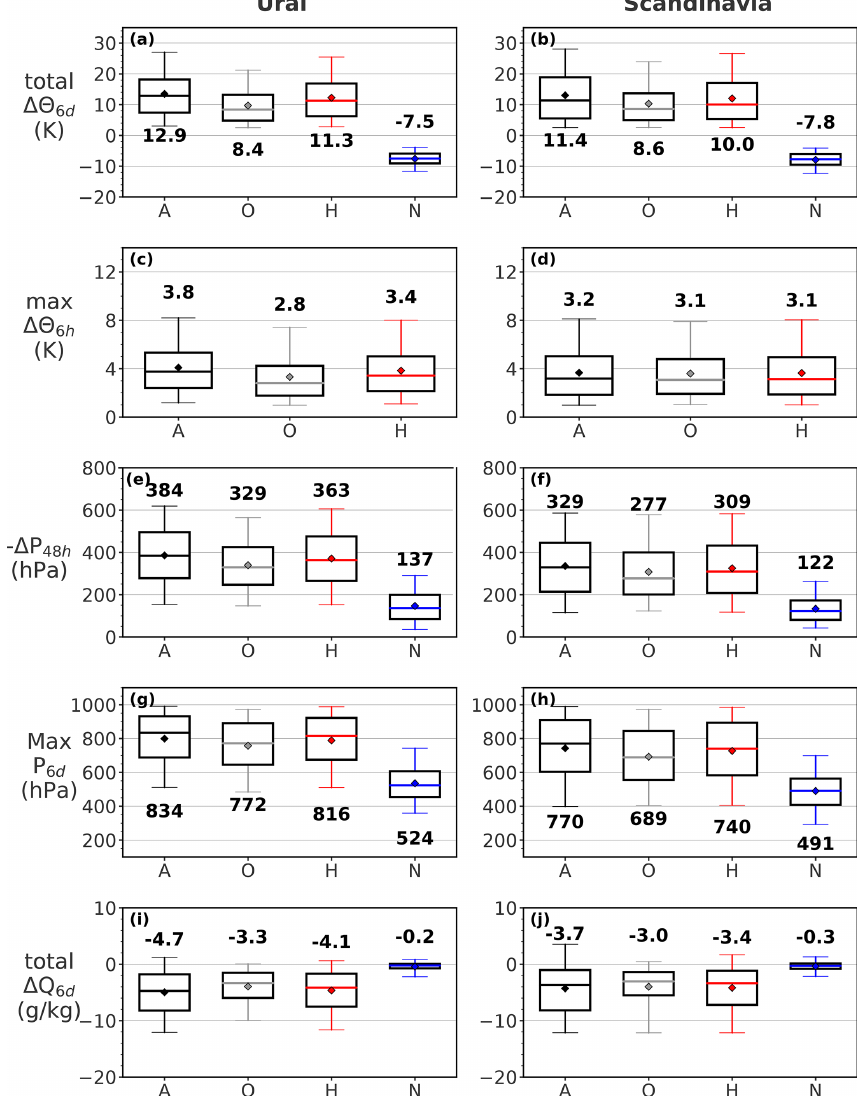
Figure 8. Statistical distributions of maximum absolute change in potential temperature (K) (a, b) , maximum 6-hourly change in potential temperature (K) (c, d) , maximum absolute ascent (hPa) within 48h (e, f) , maximum pressure (hPa) (g, h) and maximum change in specific humidity (gkg − 1 ) (i, j) along the 6d back trajectories belonging to the non-heating regime (N, blue lines) and heating regime (H, red lines), initialized from both Ural (first column) and Scandinavian (second column) blocks. The heating regime is further subdivided into trajectories experiencing maximum heating in the main domain (A, black lines) and outside the domain (O, gray lines). The second row is only shown for heated trajectories. The whiskers show the 5th–95th percentile range, the box shows the interquartile range and the mean is shown as diamonds. Horizontal lines and the bold values denote the median for each